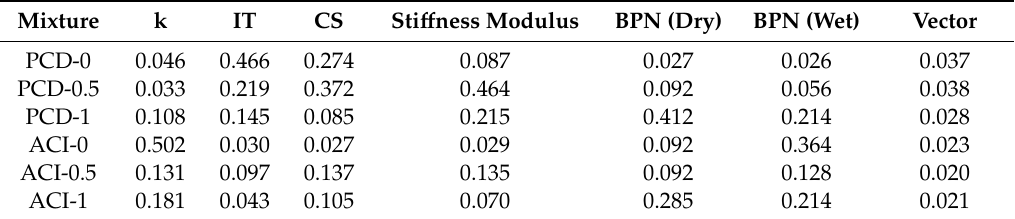
Table 6. Mixtures’ vector and variables’